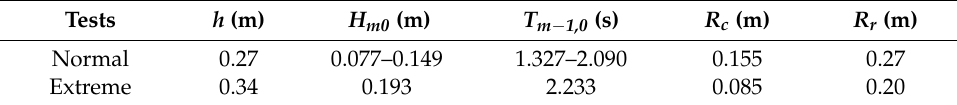
Table 1. The characteristics of the ordinary and extreme wave conditions.